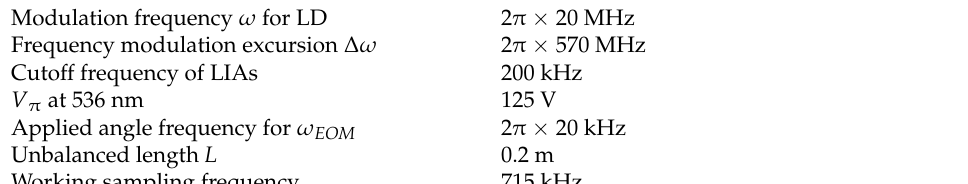
Table 1. The experimental conditions for the virtual displacement measurement.